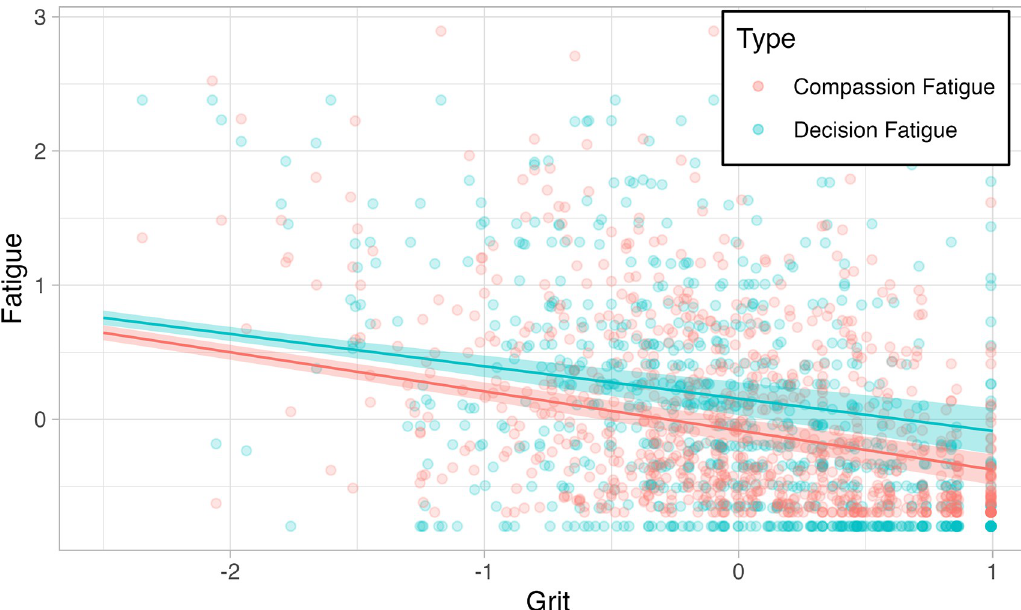
Fig 1. Inverse relation between grit and compassion fatigue & grit and decision fatigue. Lines show means and shaded areas 95% confidence intervals.